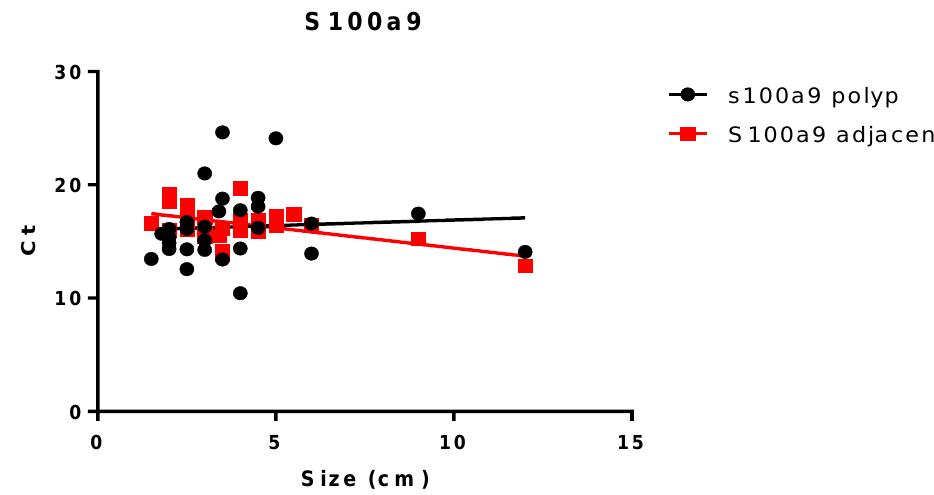
Figure 6. S100A9 correlation expression in polyp or adjacent tissue vs. size of lesion. Data are expressed as ΔCt.